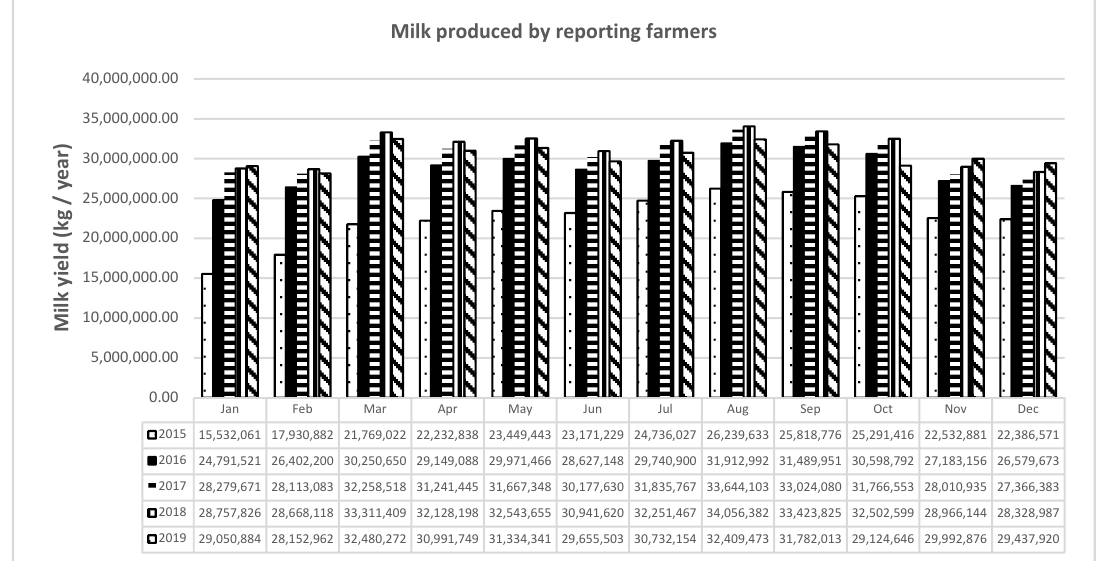
Figure 1. Milk produced by reporting farmers.